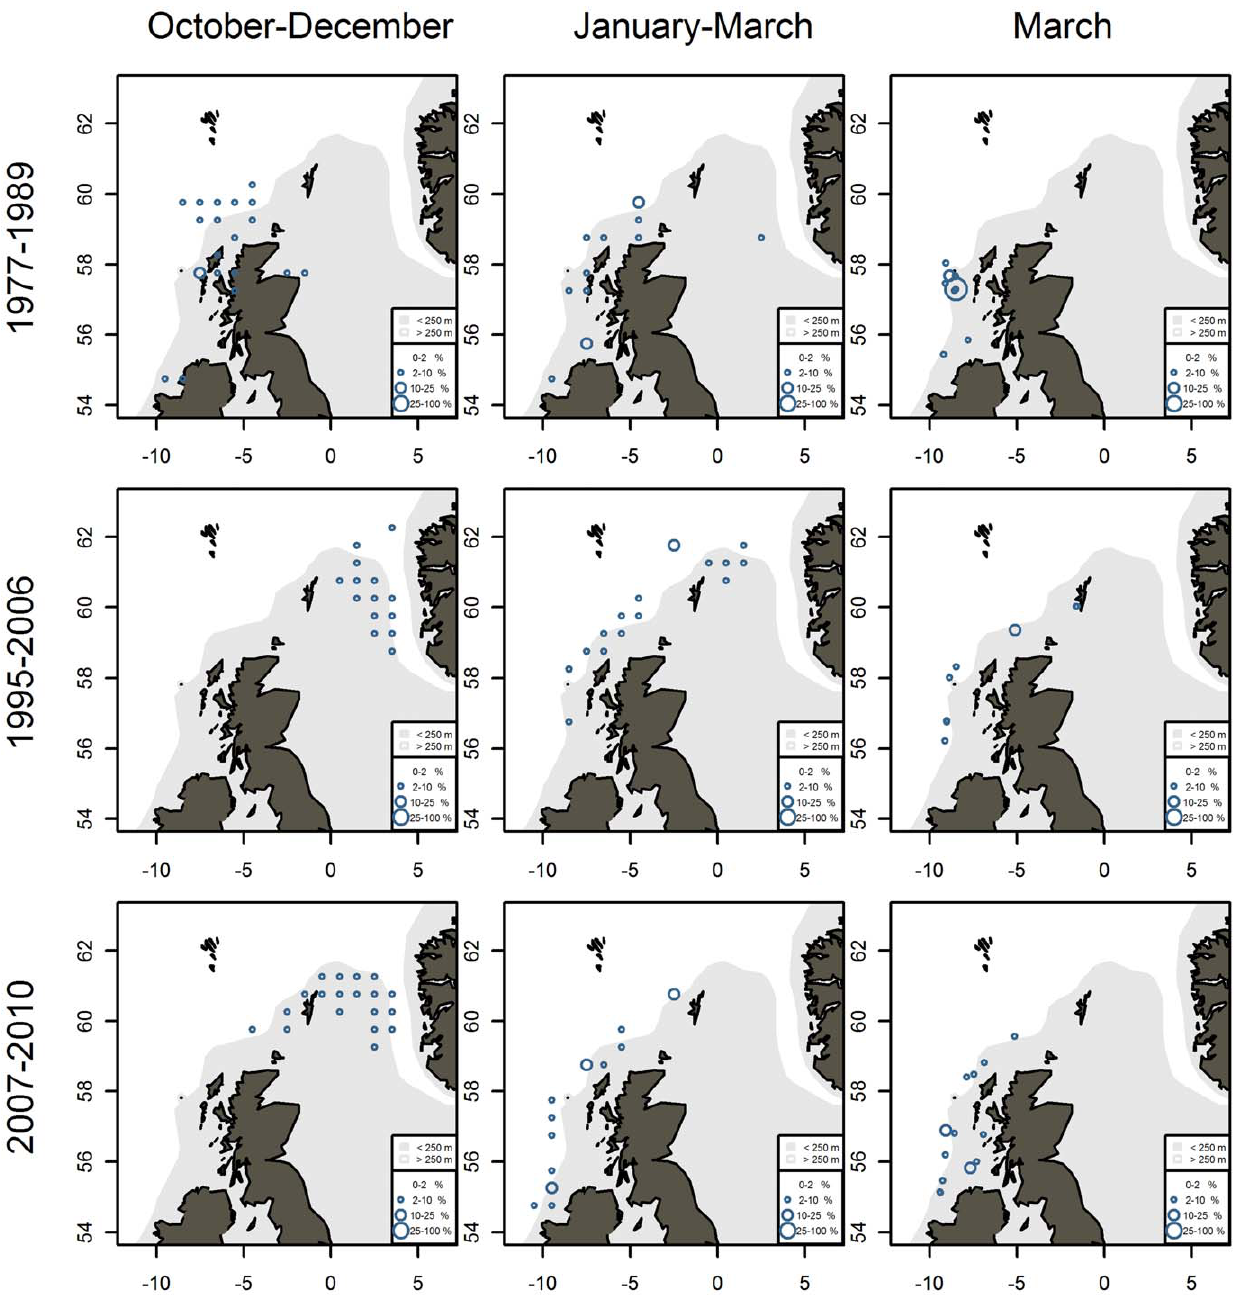
Figure 8. Relative distribution of mackerel landings from the commercial fisheries and mackerel catches from fisheries independent bottom trawl surveys. Data from January–March are shifted back one year to match data in the same season from